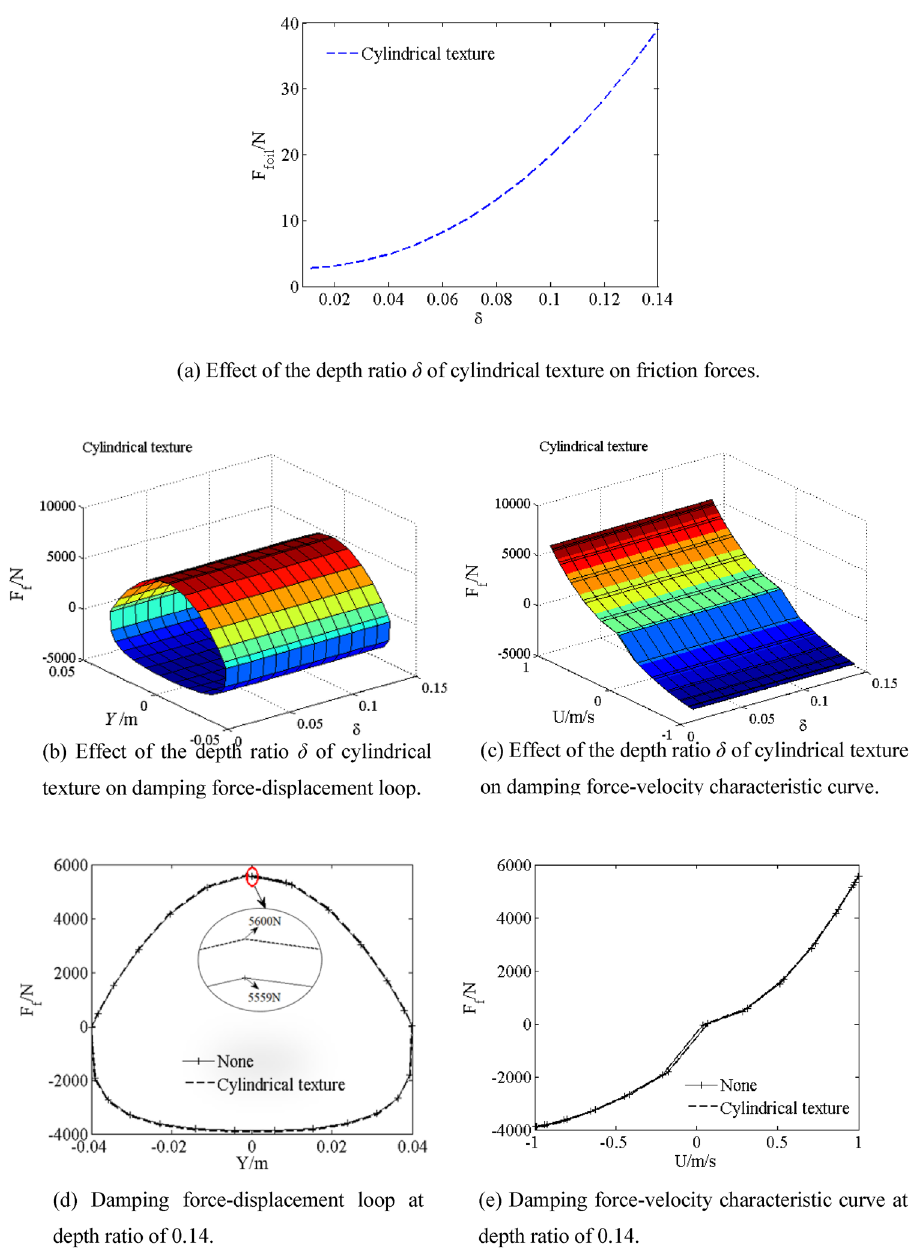
Figure 8. Effect of the depth ratio δ of cylindrical texture on damping